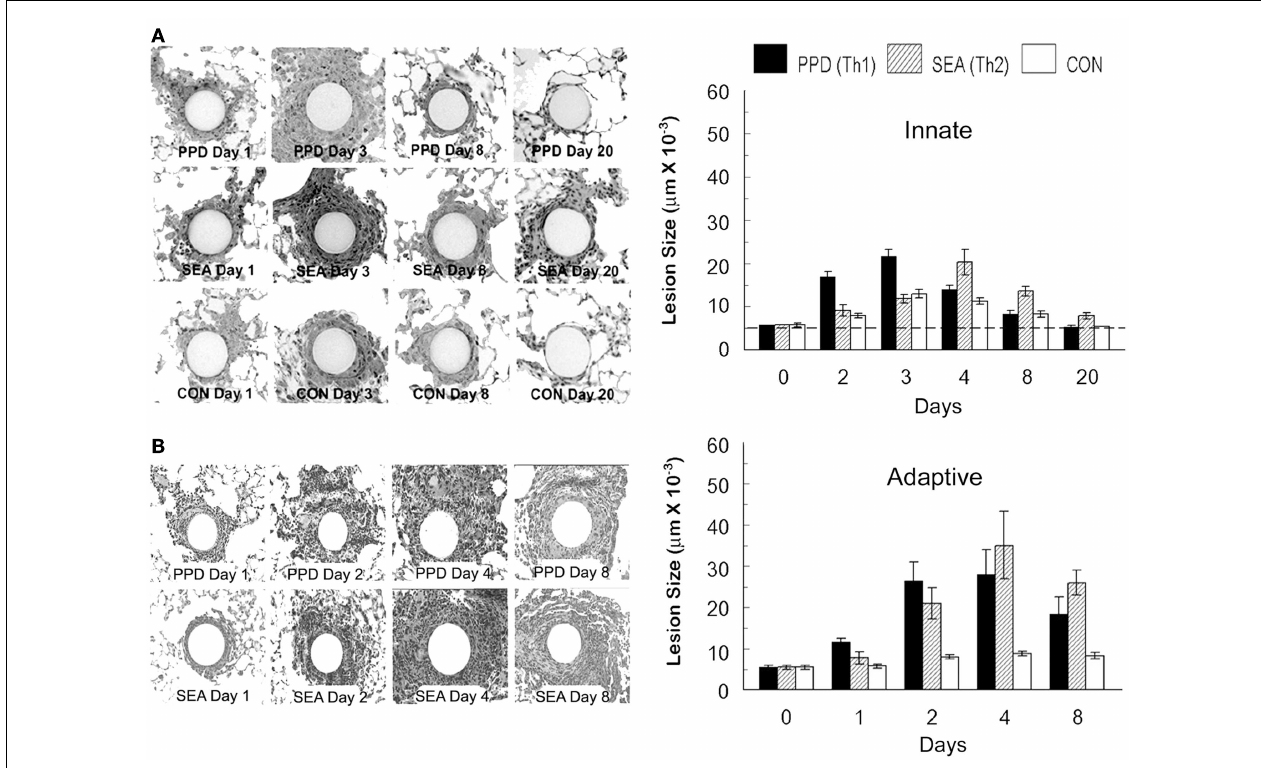
image analysis. A minimum of 20 lesions were measured. Dashed line represents average bead size. (B) Histologic appearance and sizes of adaptive antigen bead granulomas. Antigen beads were administered as above, but mice were pre-sensitized to the respective mycobacterial and schistosome egg antigens. Lungs were harvested at the designated time points for histologic examination and cross-sectional measurement as above. Size of a non-antigen coated control bead reaction is shown in chart for comparison. Bars are means and standard deviations of five